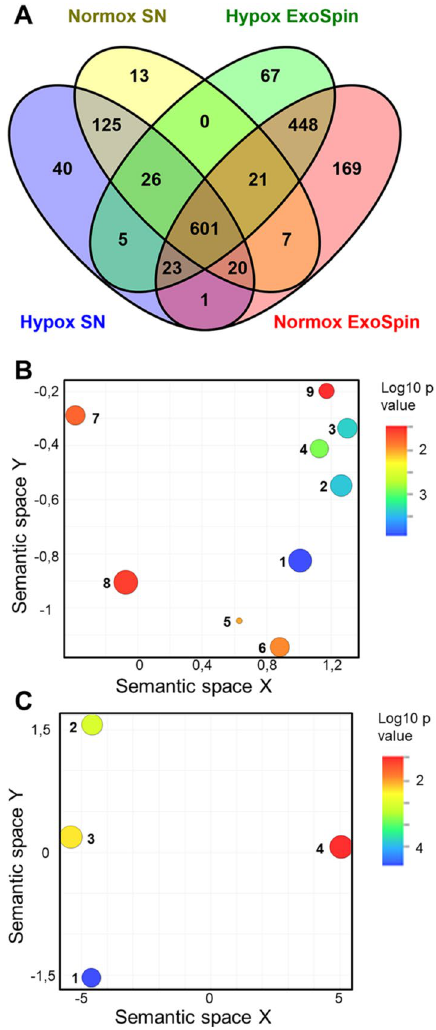
Figure 5.. Proteomics analysis of EVs released under hypoxia and normoxia. ( A ) Comparison of proteins found in Exo-spin EV samples (hypoxia and normoxia) and proteins found in EV-depleted supernatants (SN) (hypoxia and normoxia). Actual protein lists are given in Supplementary Tables S1 and S2. ( B ) GO analysis of proteins significantly different in abundance between hypoxic and normoxic EVs for “Cellular components” and ( C ) GO analysis of the same proteins for “Molecular function”. GO Cellular component: 1. Plasma membrane protein complex; 2. Plasma membrane region; 3. Basolateral plasma membrane; 4. Lateral plasma membrane; 5. Integrin alpha5-beta1 complex; 6. Integrin complex; 7. Protein complex involved in cell adhesion; 8. Membrane protein complex; 9. Invadopodium membrane. GO Molecular function: 1. Integrin binding; 2. Cell adhesion molecule binding; 3. Receptor binding; 4. Macromolecular complex